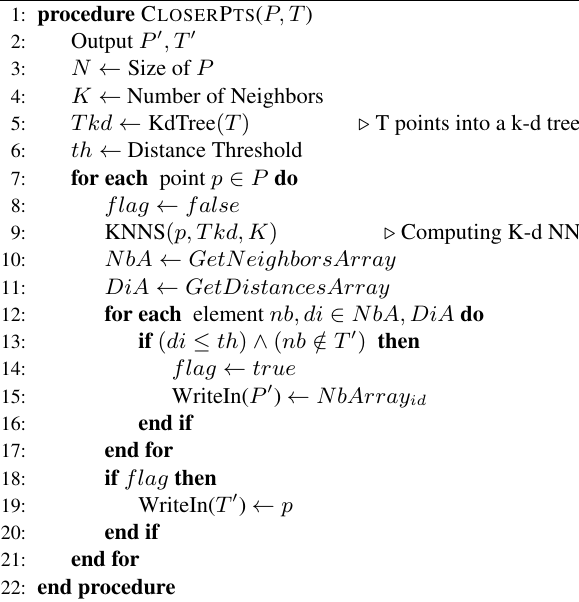
Algorithm 1 Pseudocode to retrieve the nearest point-clouds be- tween sets P and